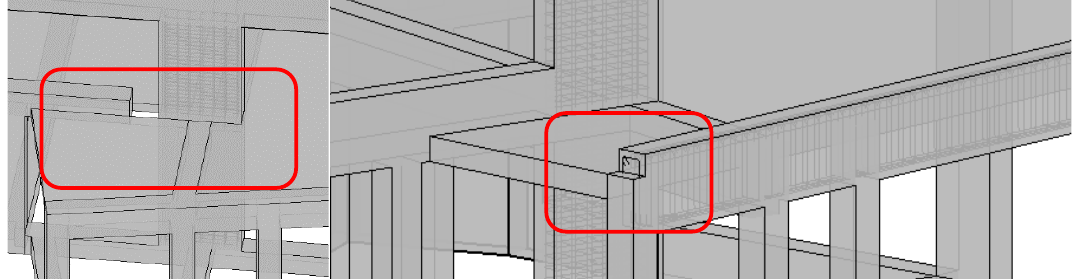
Figure 18. Incorrect eccentricity of a column and a beam.